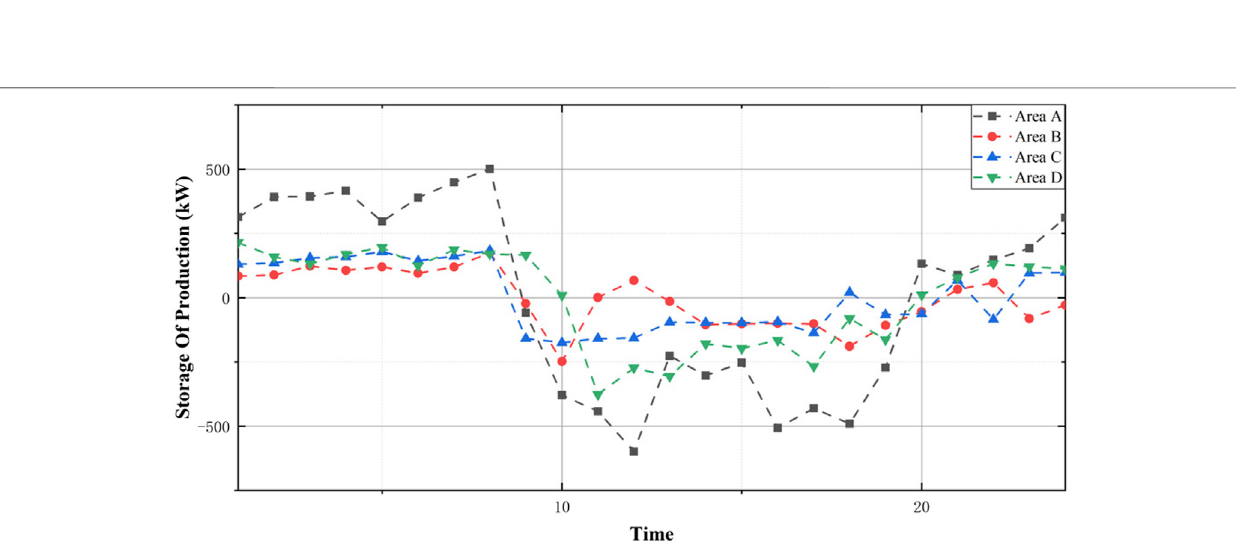
curve when all renewable energy production capacity is fully used in real time. Compared with the blue curve representing the fi nal